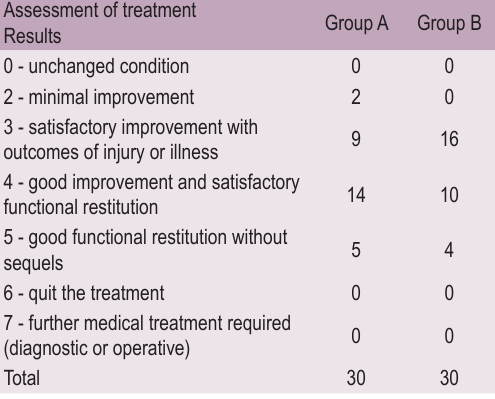
TABLE 5. Results of treatment